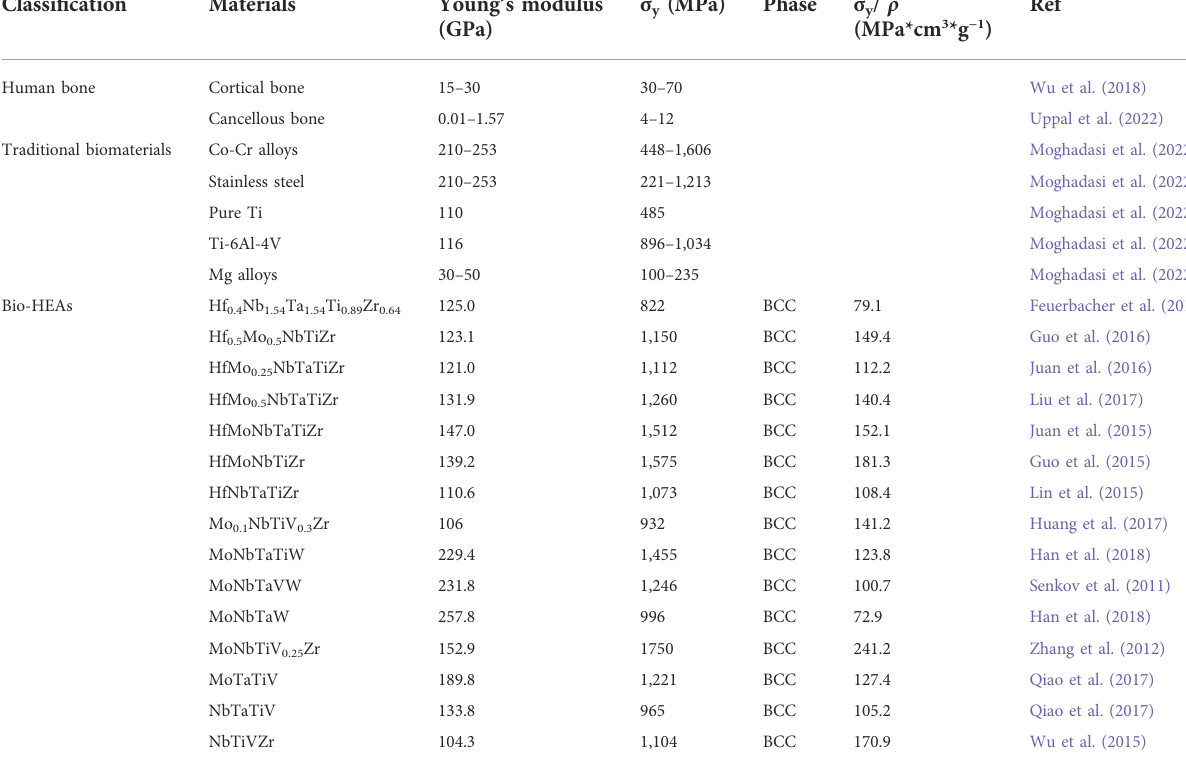
TABLE 3 Mechanical properties of human bone, traditional biomaterials, and Bio-HEAs.